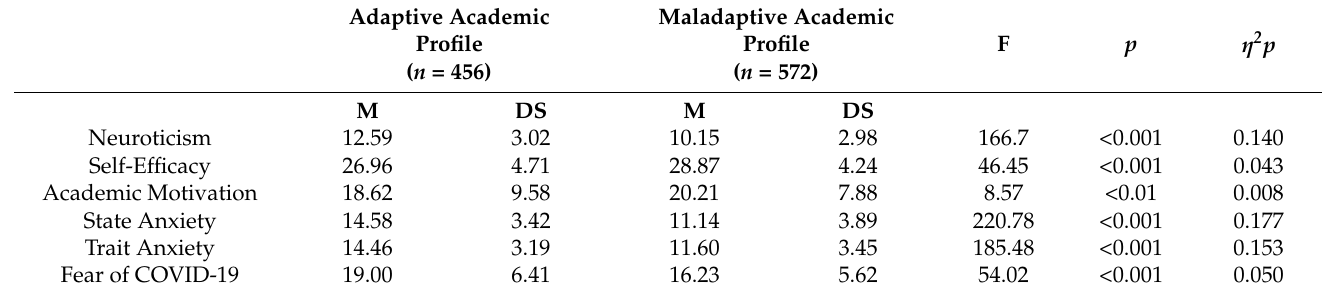
Table 3. MANOVA results on study variables for Adaptive and Maladaptive Academic Profiles.